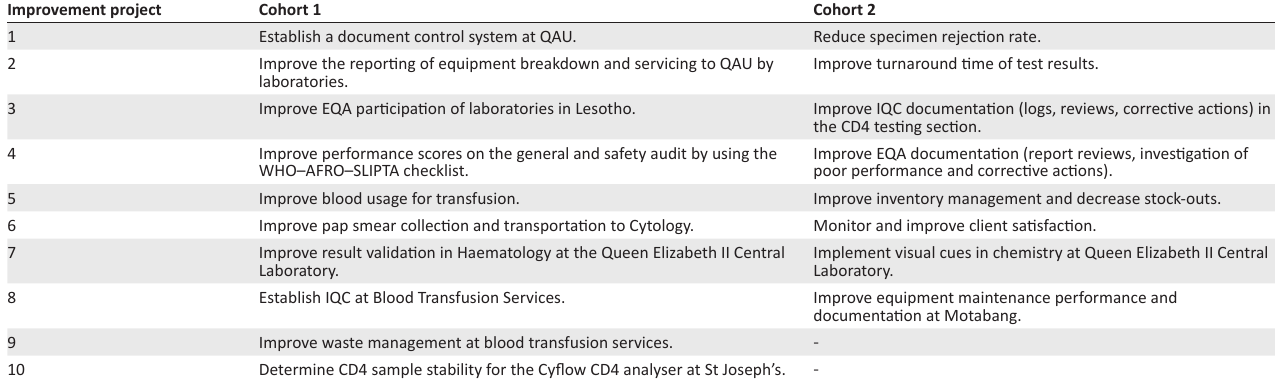
TABLE 3: List of improvement projects carried out by Cohort 1 and Cohort 2 participants in the Strengthening Laboratory Management Towards Accreditation (SLMTA) programme in Lesotho. Improvement